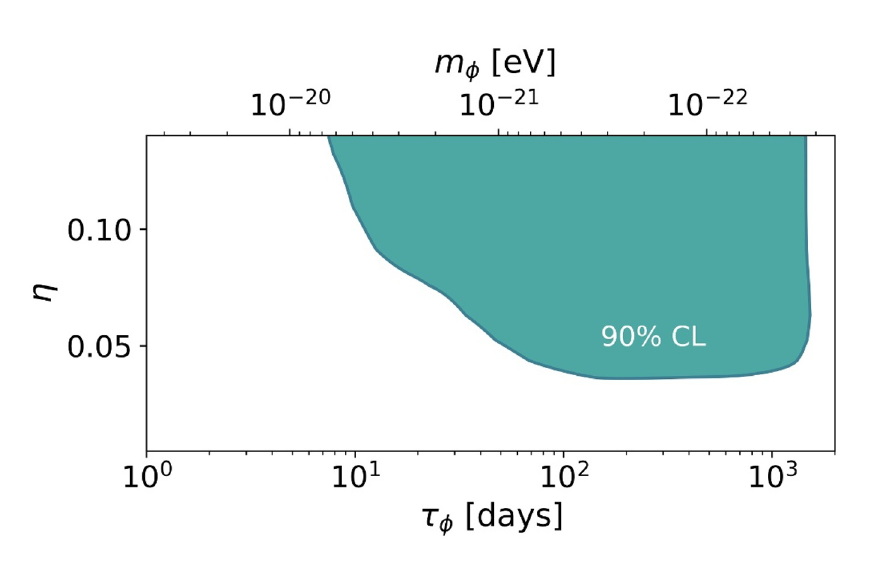
Figure 6 . Region in the modulation amplitude η versus period τ φ plane for which the analysis performed using the Lomb-Scargle periodogram would be capable to state at a 90 % C.L. that the periodic signal found in 7 years of DUNE data would not be spurious. Upper x-axis presents the corresponding range for the mass of the ultralight scalar, m φ